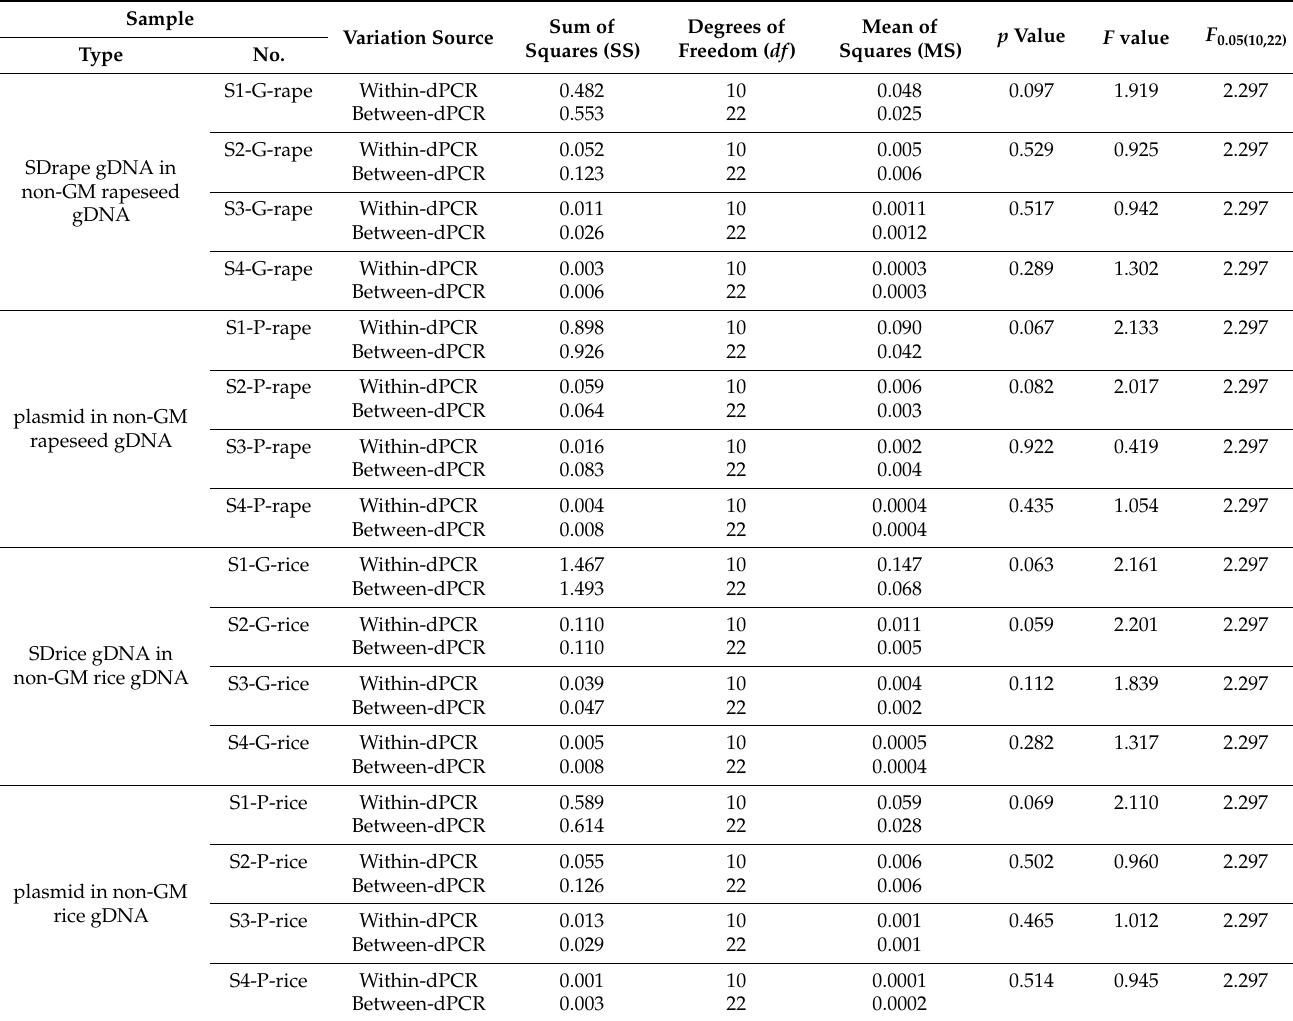
Table 2. Statistical analysis of one-way analysis of variance of the quantitative data of the test samples by dPCR